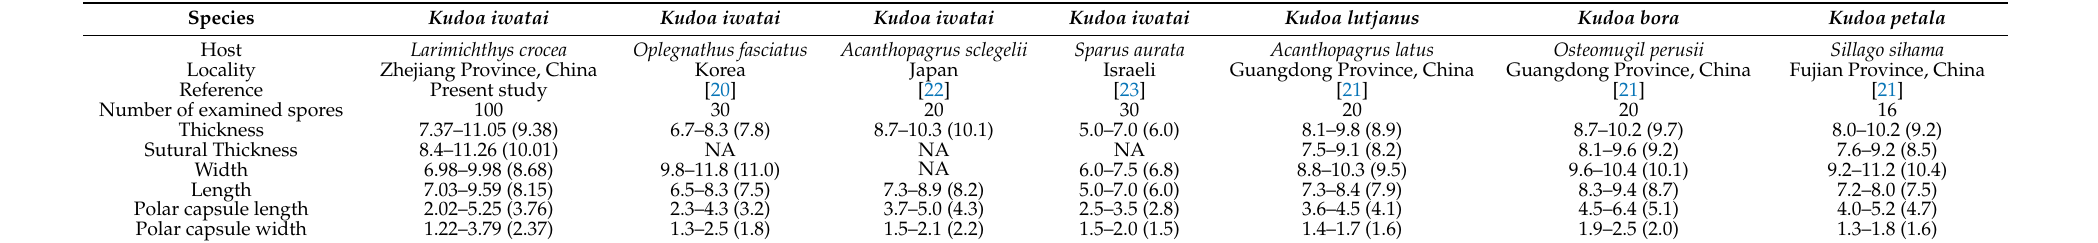
Table 2. Measurements of Kudoa spp. mature